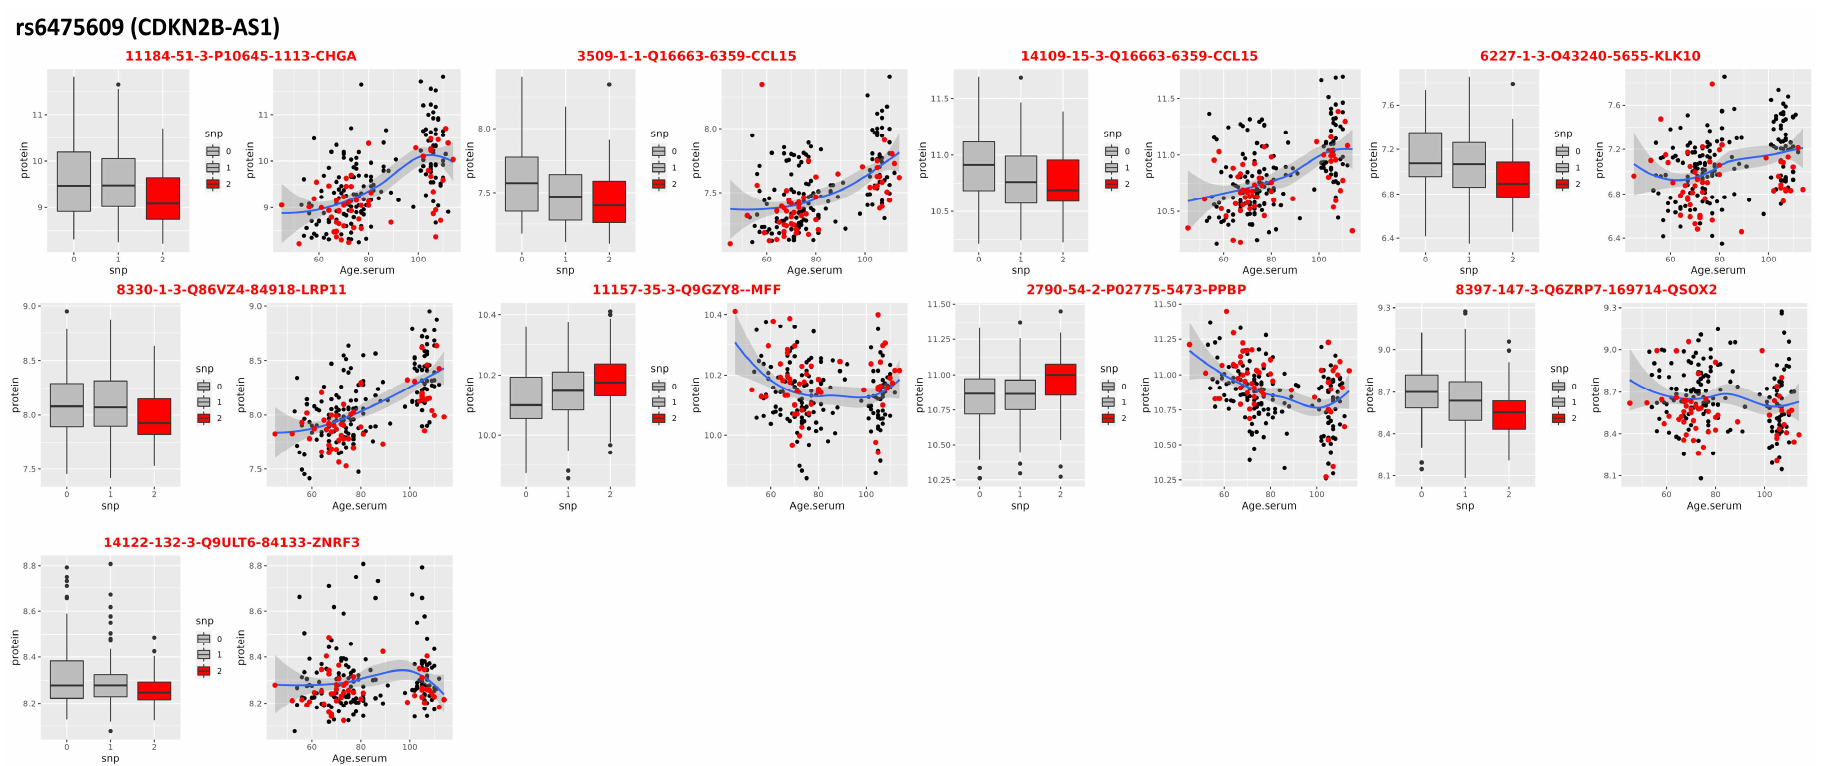
Figure 3. pQTLs in CDKN2B-AS1. Nine aptamers mapping to eight proteins that correlate with genotypes of the SNP rs6475609 in the CDKN2B-AS1 that was associated with extreme human longevity in the discovery GWAS. For each protein: the boxplots on the left show the distribution of the log-transformed protein data by genotype group (red = homozygote genotype for the longevity allele; gray/black = genotypes of carriers of 1 or 2 non-longevity alleles); the scatter plot on the right shows the distribution of the log-transformed protein data ( y -axis) versus the age of study participants ( x -axis).